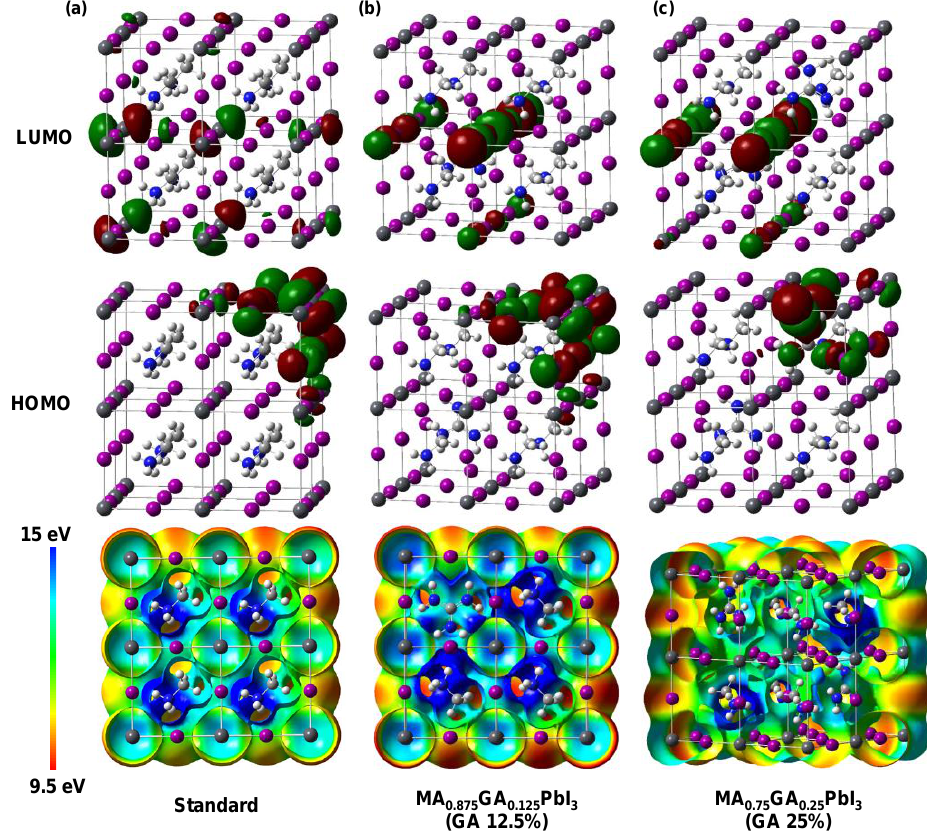
Figure 2. LUMO, HOMO, and cutaway view of electrostatic potential for ( a ) MAPbI 3 , ( b ) MA 0.875 GA 0.125 PbI 3 , and ( c ) MA 0.75 GA 0.25 PbI 3 .